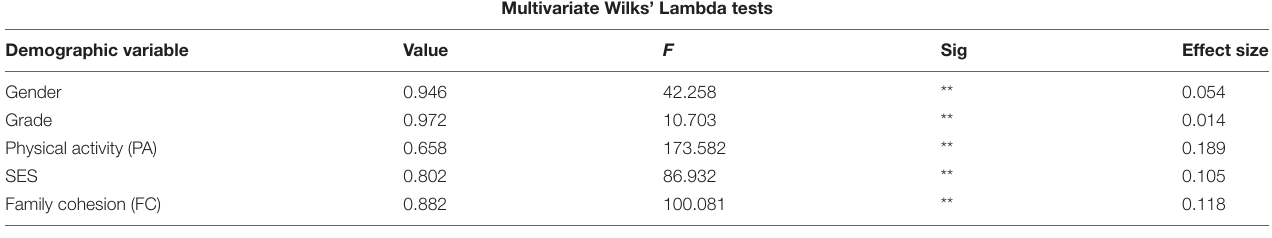
TABLE 3 | MANOVA results comparing status